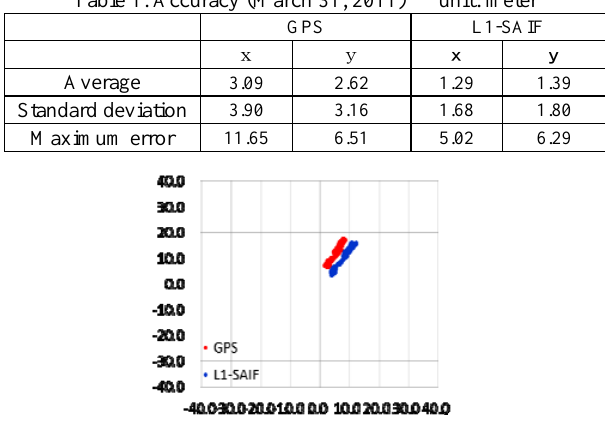
Figure 5. Positioning trajectory on the fixed point November 25, 2011 (Blue: GPS, Red: QZS1 L1-SAIF)